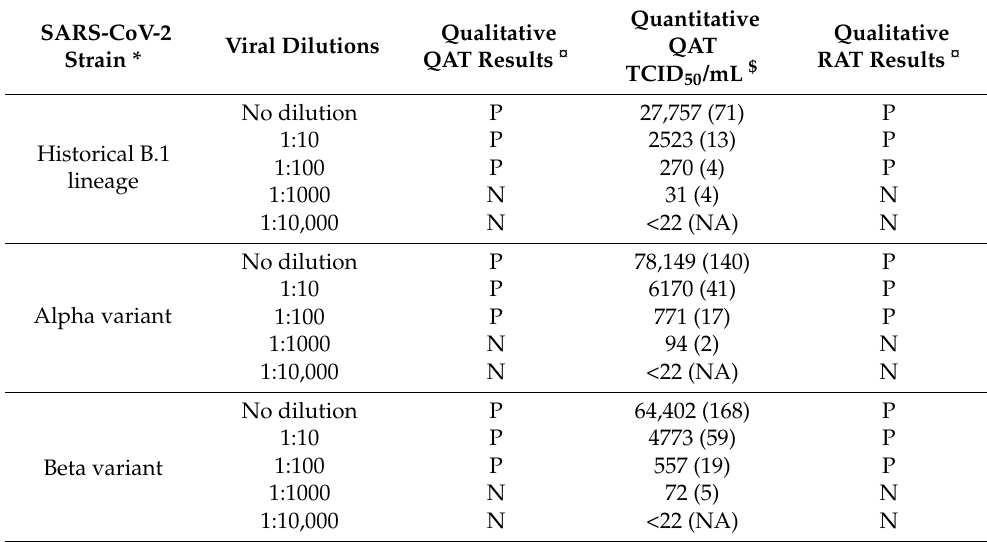
Table 2. QAT and RAT results for N antigen detection in dilutions of SARS-CoV-2 variants cell culture supernatants.